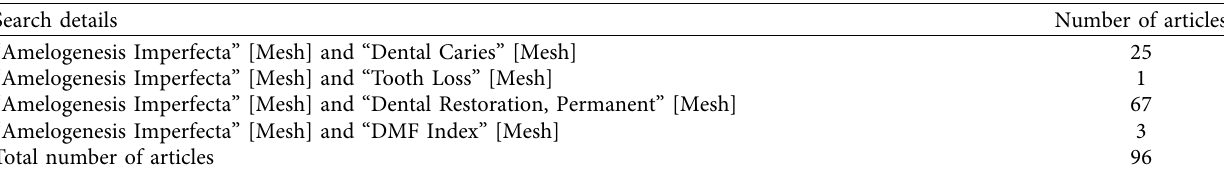
Table 1: Search strategy.